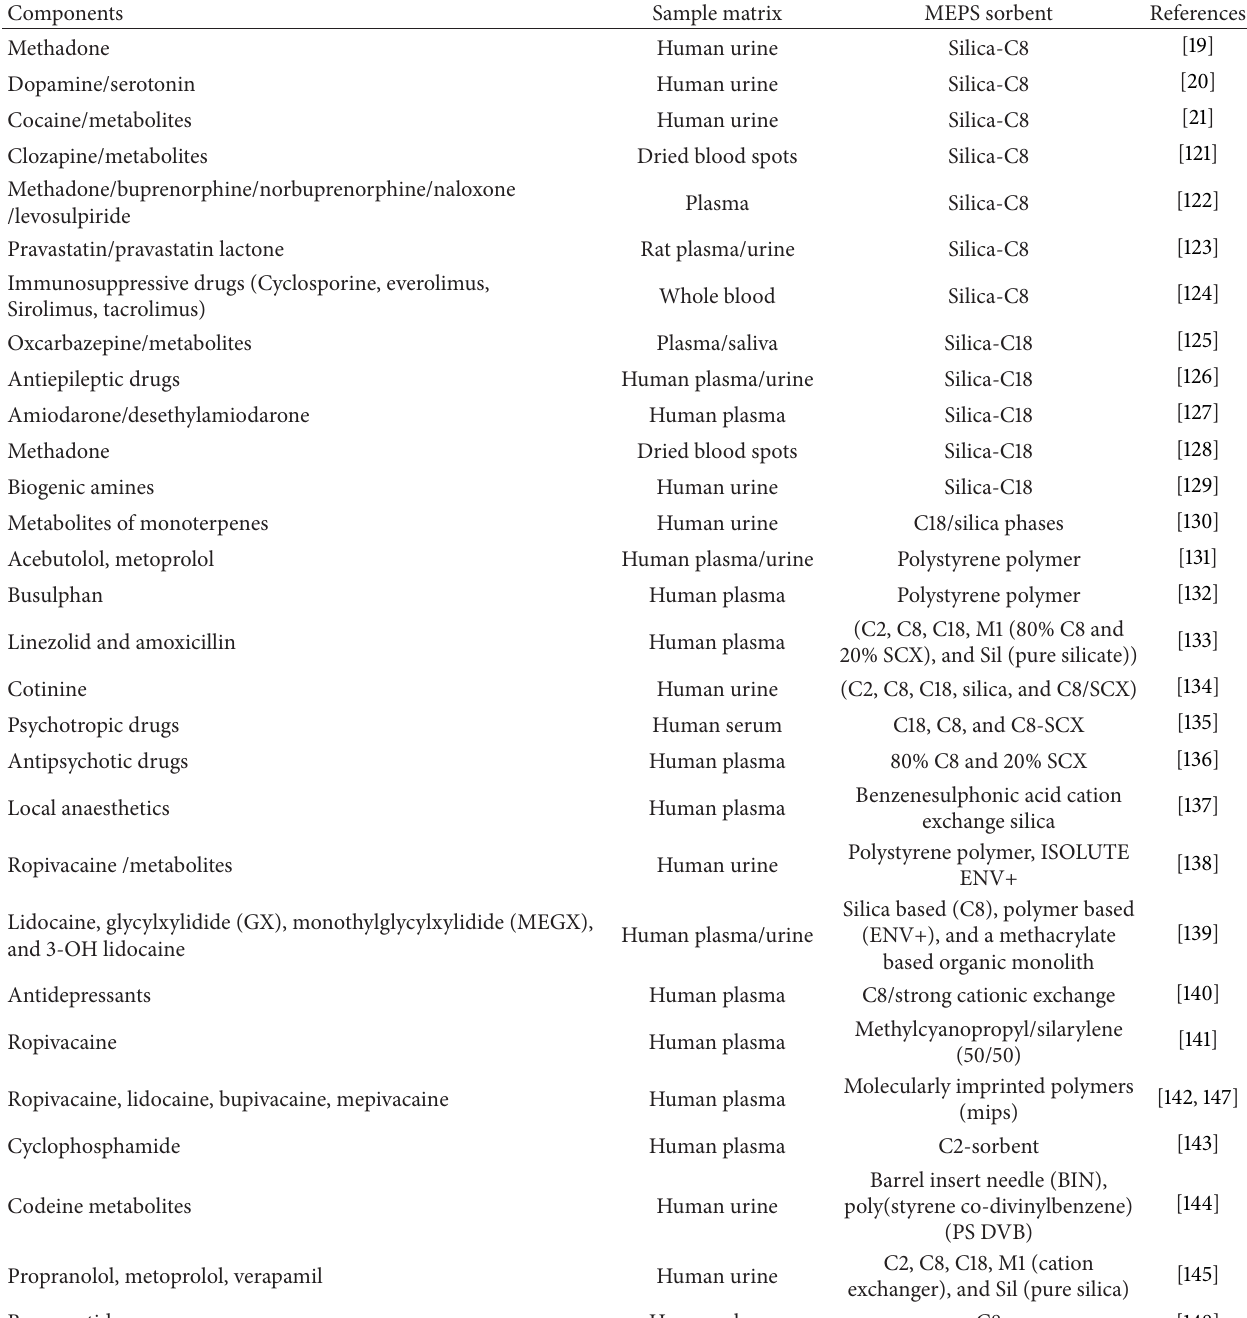
Table 3: Extraction of different analytes by MEPS